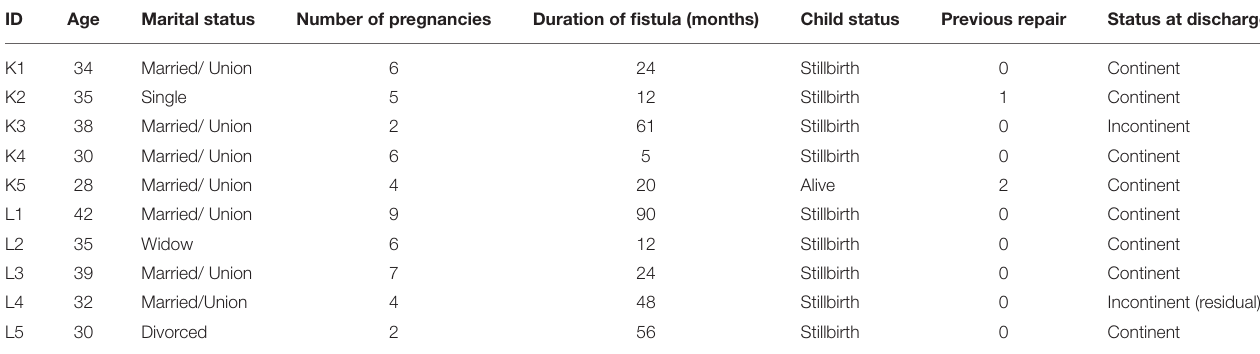
TABLE 2 | Selected sociodemographic and clinical characteristics of fistula clients interviewed in Kissidougou and Labé, Guinea,